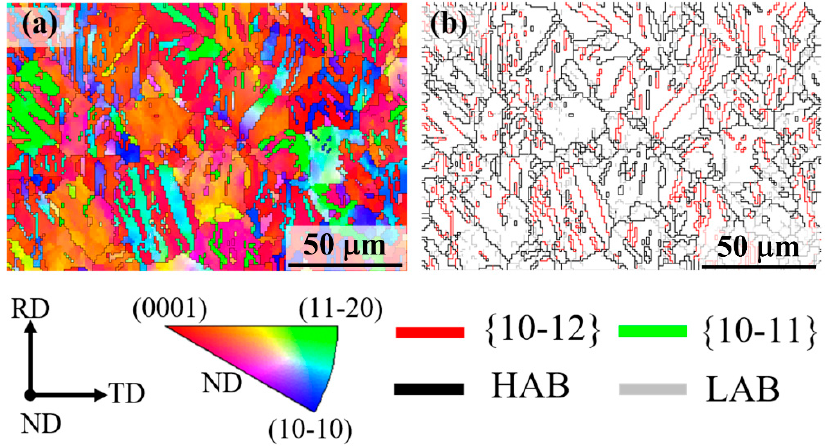
Figure 5. EBSD maps of the ECAR-CB AZ31 Mg alloy sample at final rolling temperature of 350 °C: ( a ) inverse pole figure (IPF) map and ( b ) grain boundaries (GB) ( a ) inverse pole figure (IPF) map and ( b ) grain boundaries (GB) map.